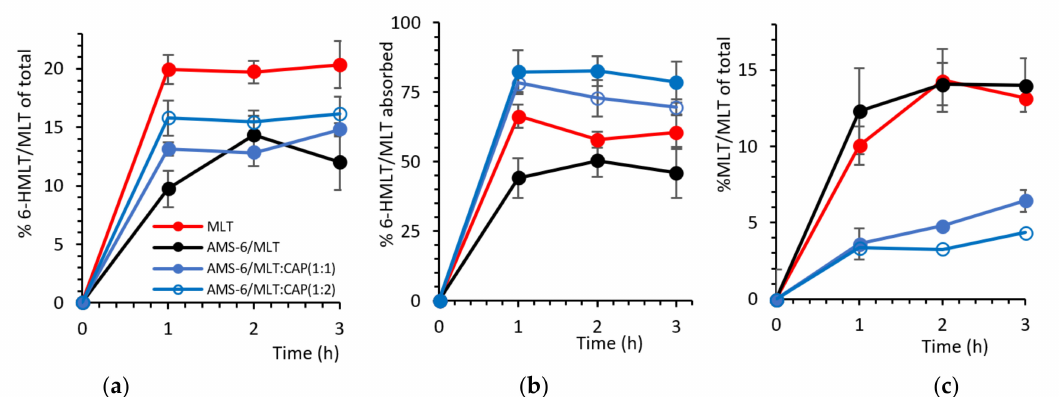
Figure 5. ( a ) The formation of 6-hydroxy melatonin (6-HMLT) as a molar percentage of the total mLT added on the apical side versus time. ( b ) The molar percentage of 6-HMLT as a function of the total mLT absorbed on the basolateral side. ( c ) Remaining mLT after the enzymatic reaction as a molar percentage of the total mLT added on the apical side versus time. Every data point represents the average value obtained from a triplicate sample, and the error bars correspond to the calculated standard